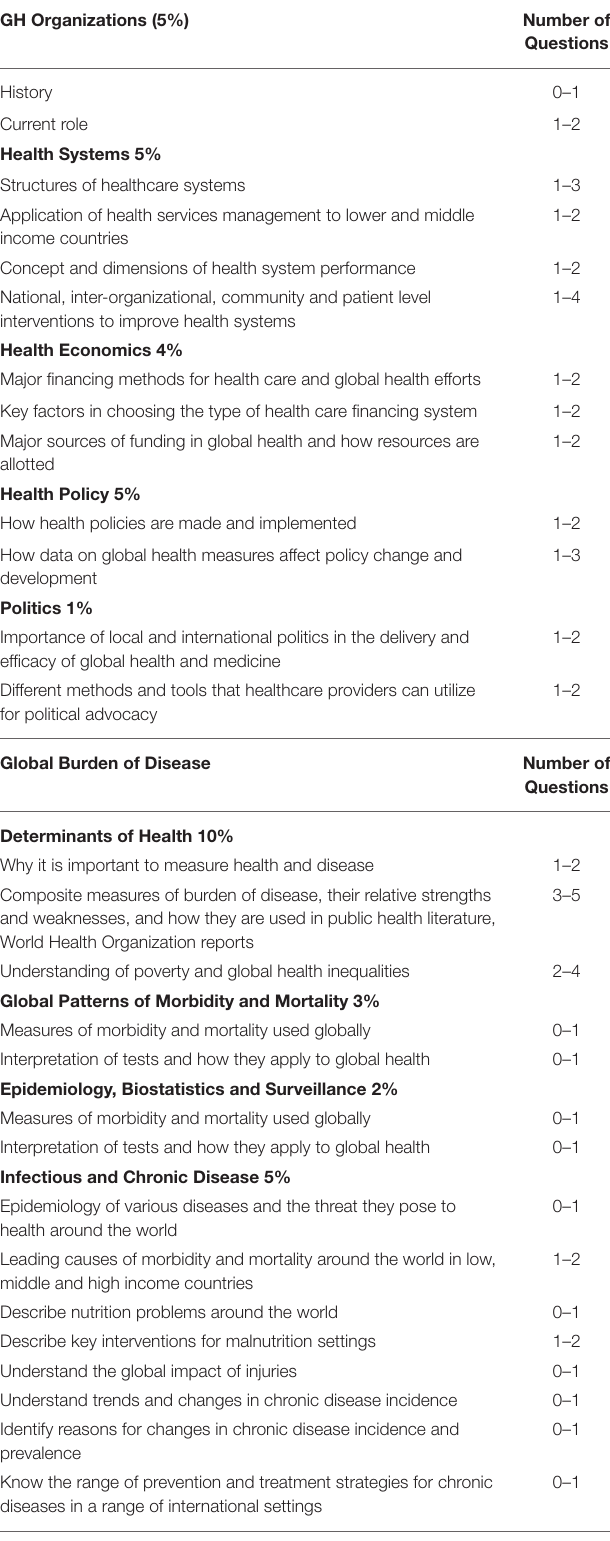
TABLE 4 | MCQ Blueprint for global health learning